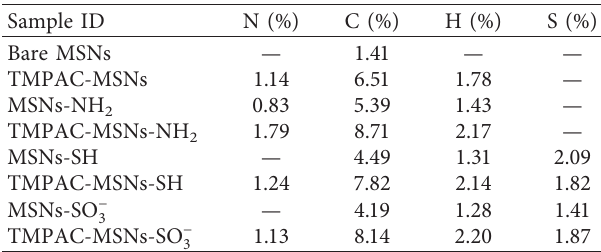
Figure 3: FT-IR spectra obtained for (a) bare MSNs, (b) TMPAC- . MSNs, (c) TMPAC-MSNs-NH 2 , (d) TMPAC-MSNs-SH, and (e) 3 . TMPAC-MSNs-SO − 3 Table 2: Elemental analysis data obtained for the fabricated mesoporous silica